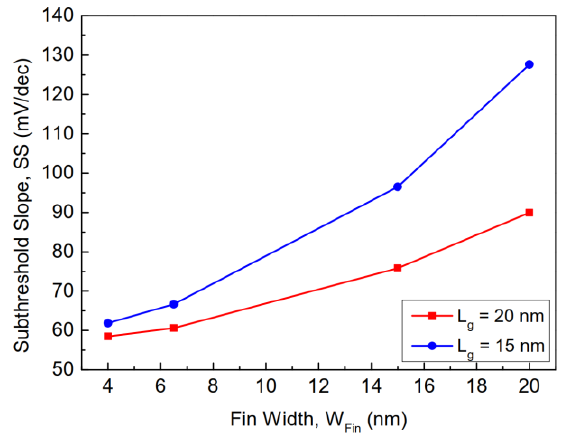
Figure 21. Behavior of the subthreshold slope as a function of fin width for FinFET devices with two different gate lengths at V ds = 0.05 V.